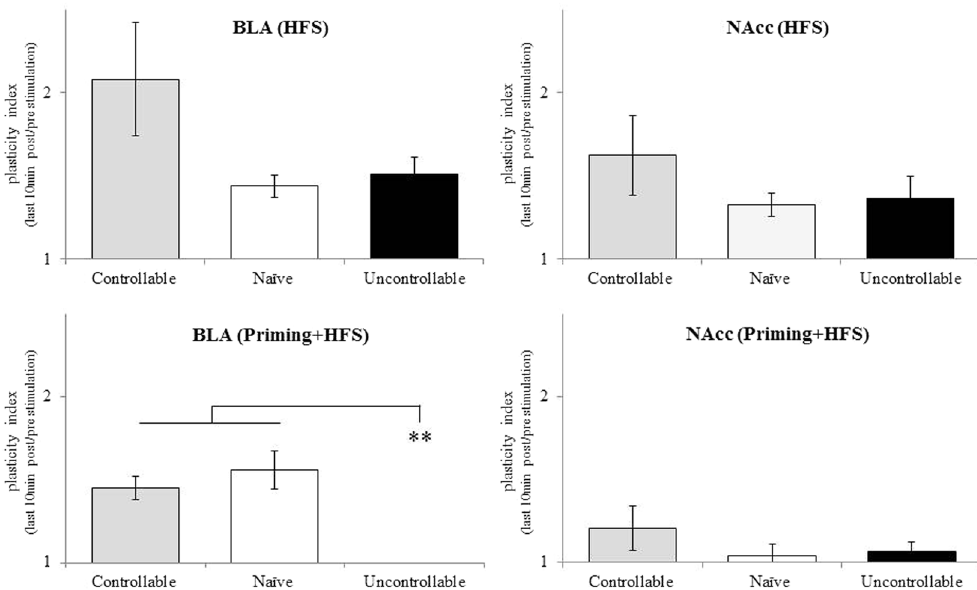
Figure 5. The interactive effects of group X stimulation protocols: between groups effects: under HFS stimulation a border-line significance for higher BLA plasticity index in controllable rats was evident compared to naïve rats (p = 0.08). Under 0.5 mA priming + HFS, both controllable and naïve rats exhibited higher BLA plasticity indices compared to uncontrollable rats ( ** <